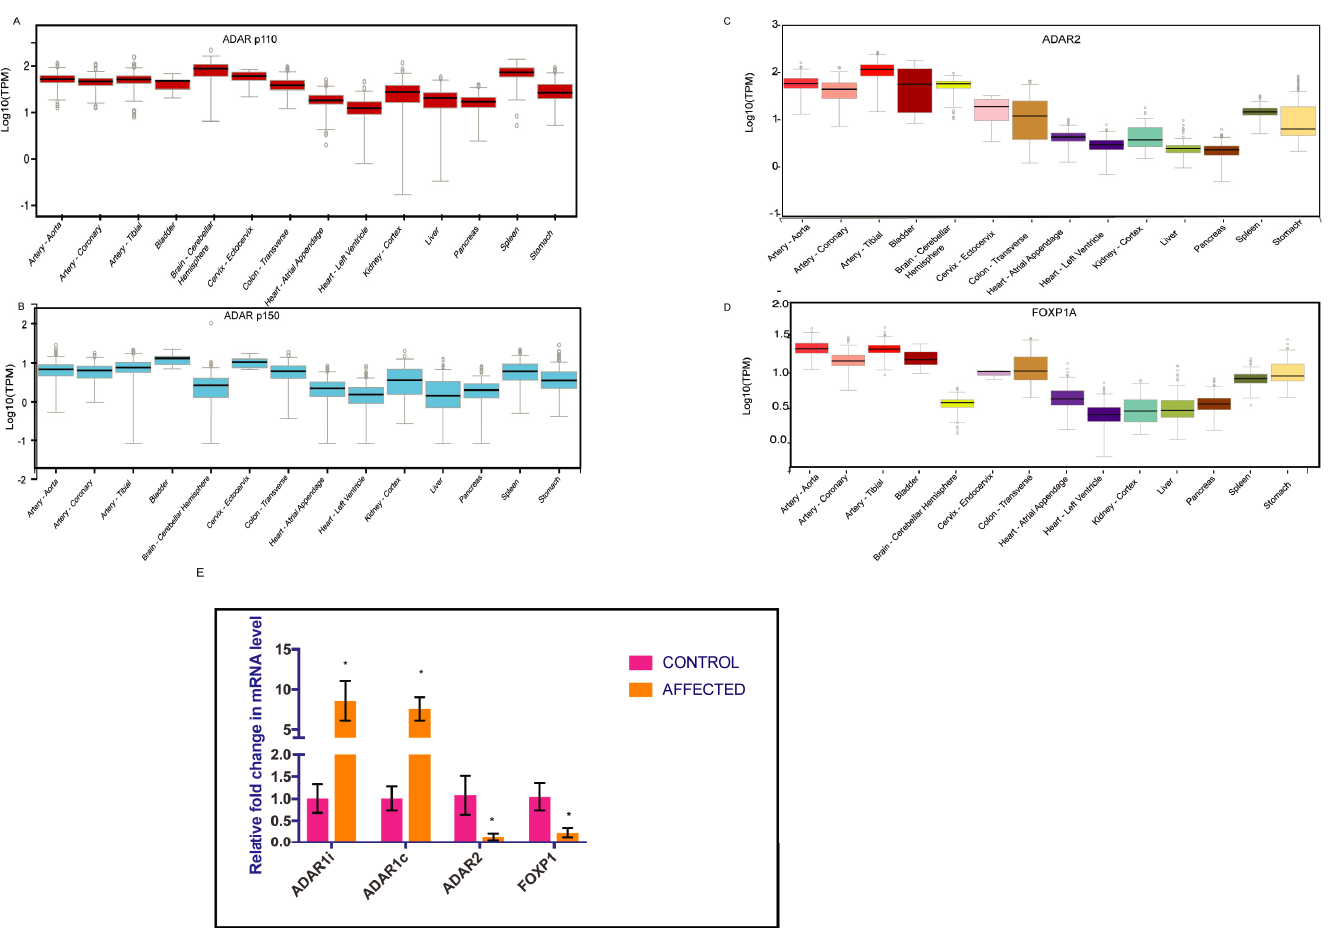
Fig 1. ADAR2 expression is reduced in CHD patients. ( A) ADAR1 p110 is strongly expressed in brain cerebral hemispheres as compared to left heart ventricle. The Y- axis represented the log10 of the transcript per million (TPM) value. The whiskers represent the maximum and minimum values. The median is represented as a black line in the box. (B) The expression of ADAR1 p150 is strongest in the bladder, followed by the cervix and tibial artery. ADAR1p150 expression is slightly higher in the left heart ventricle as compared to cerebral hemisphere. The whiskers represent the maximum and minimum values. The median is represented as a black line in the box. (C) ADAR2 expression is strongest in the tibial artery, followed by the bladder, stomach aorta and coronary artery. The whiskers represent the maximum and minimum values. The median is represented as a black line in the box. (D) FOXP1 expression is strongest in the aorta, followed by the tibial artery and bladder. The whiskers represent the maximum and minimum values. The median is represented as a black line in the box. (E) Bar graph showing the relative RNA levels of ADAR1, ADAR2 and FOXP1 in patients compared to controls. ADAR2 and FOXP1 showed significantly reduced expression at the RNA level, whereas both isoforms of